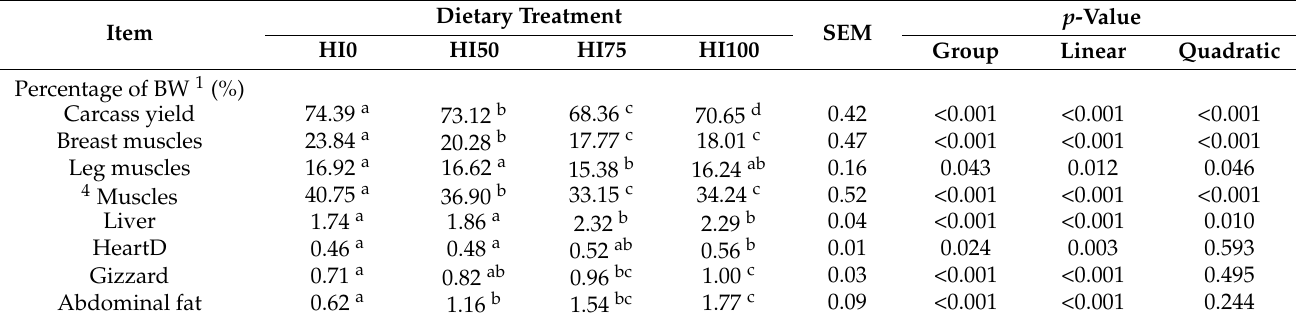
Table 5. Carcass yield and percentage share of muscles, selected internal organs and abdominal fat (% of BW 1 ) in broiler chickens fed diets with different levels of full-fat Hermetia illucens (HI) 2 larvae meal (%, arithmetic mean, SEM 3 ; values on d 42, n =